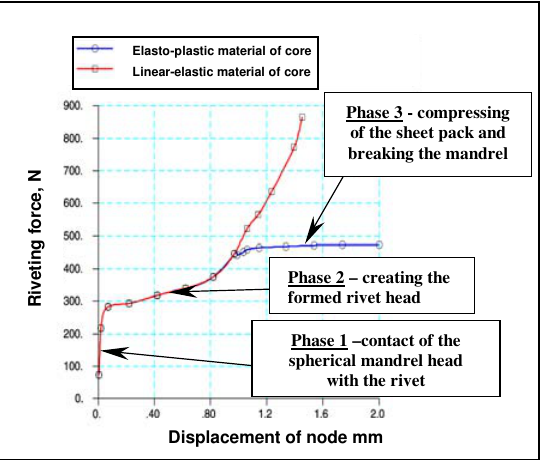
Fig 7. Plot of riveting forces for different friction coefficients defined between the rivet and the spherical surface of